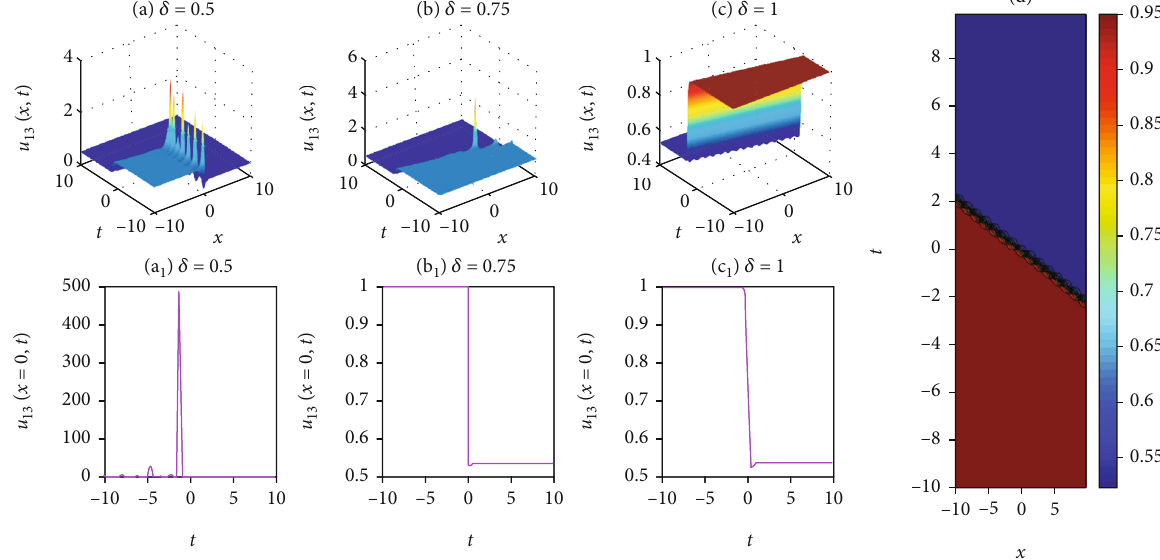
ð x , t Þ . (a – c) 3D plots. (a 13